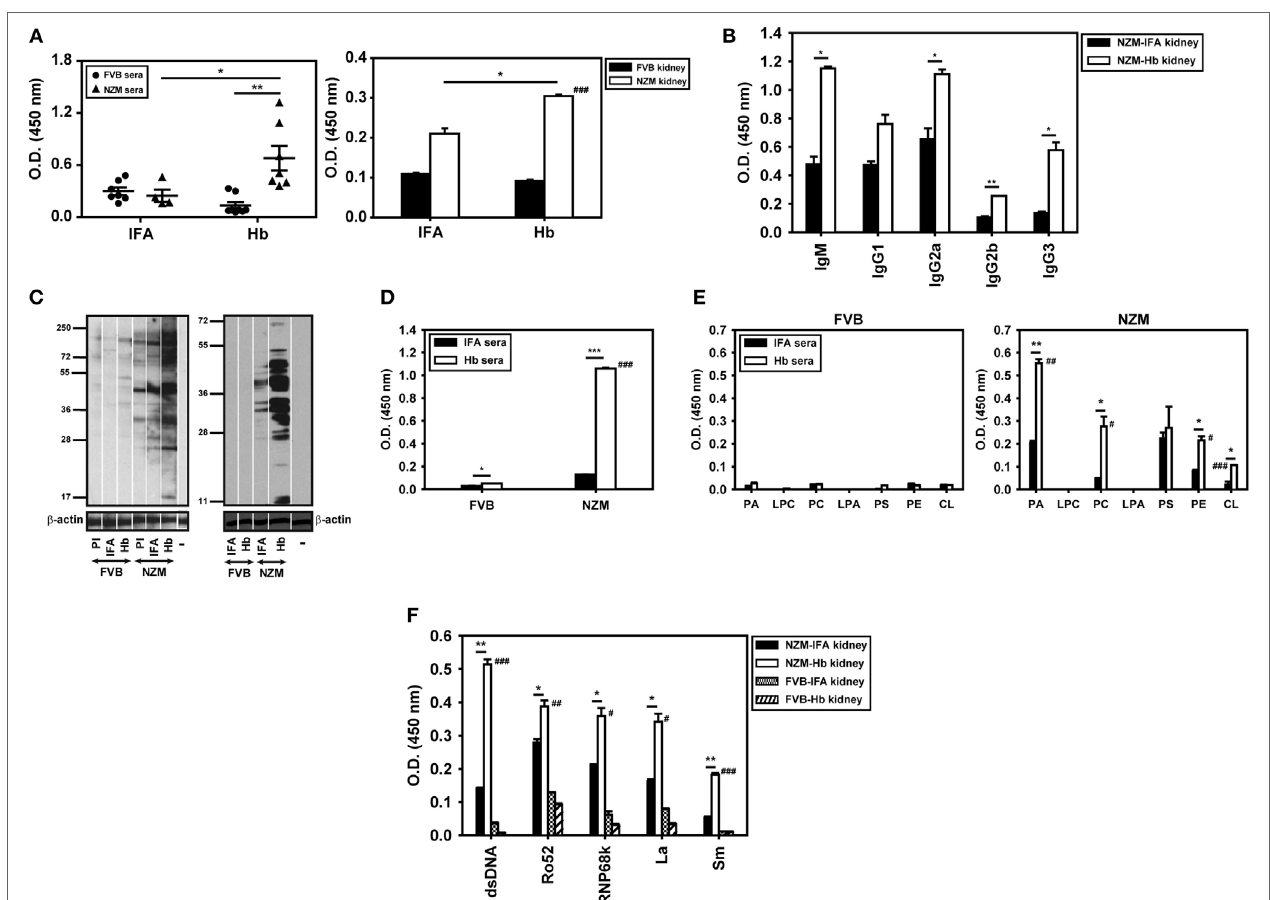
FigUre 6 | Anti-hemoglobin (Hb) autoantibody responses and autoreactivity of antibodies in sera (9 weeks after the initiation of immunization) and in kidney eluates (16 weeks after the initiation of immunization) of Hb-immunized FVB and NZM mice. (a) Anti-Hb antibodies in sera (left panel) and in kidney eluates (right panel) of incomplete Freund’s adjuvant (IFA)- and Hb-immunized NZM and FVB mice. Symbols in the left panel represent individual mice ( n = 8) and mean ± SEM are also depicted. (B) Isotype analysis of anti-Hb antibodies in kidney eluates from Hb- and IFA-immunized NZM mice ( n = 8). (c) (Left panel) Reactivity of antibodies in pooled sera ( n = 8) from Hb- and IFA-immunized FVB and NZM mice toward moieties in cellular lysate by Western blot. (Right panel) Reactivity of antibodies in kidney eluates ( n = 8) from Hb- and IFA-immunized FVB and NZM mice toward moieties in apoptotic blebs by Western blot. “PI,” pre-immune serum; “ − ,” secondary antibody control. Antibodies to β -actin were employed to verify equivalence of loading. (D) Anti-dsDNA antibodies in pooled sera ( n = 8) from Hb- and IFA-immunized FVB and NZM mice. (e) Antibodies against phospholipids in pooled sera ( n = 8) from Hb- and IFA-immunized FVB (left panel) and NZM (right panel) mice. (F) Reactivity against dsDNA and ribonucleoproteins (Ro52, RNP68K, La, Sm) of antibodies in kidney eluates ( n = 8) of Hb- and IFA-immunized FVB and NZM mice. In all bar graphs, data represent mean ± SEM. # p < 0.05, ## p < 0.005, ### p < 0.001 vs Hb-immunized FVB mice, * p < 0.05, ** p < 0.005, *** p <